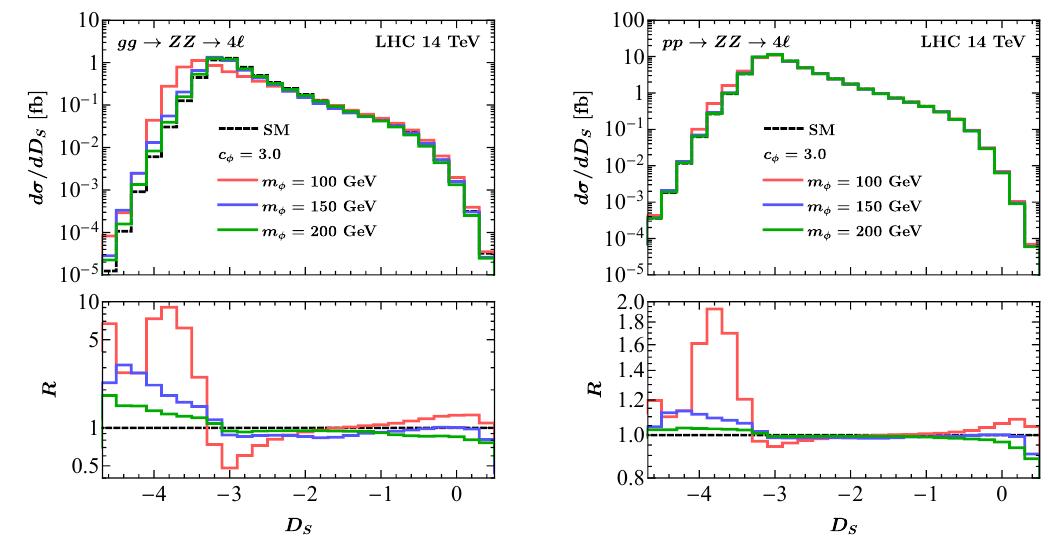
Figure 3 . As figure 2 but for the QCD-improved ME-based discriminant D S as defined in (3.1) and (3.2). Furthermore, instead of m φ = 70 GeV a mass of m φ = 200 GeV is employed. For additional explanations see main